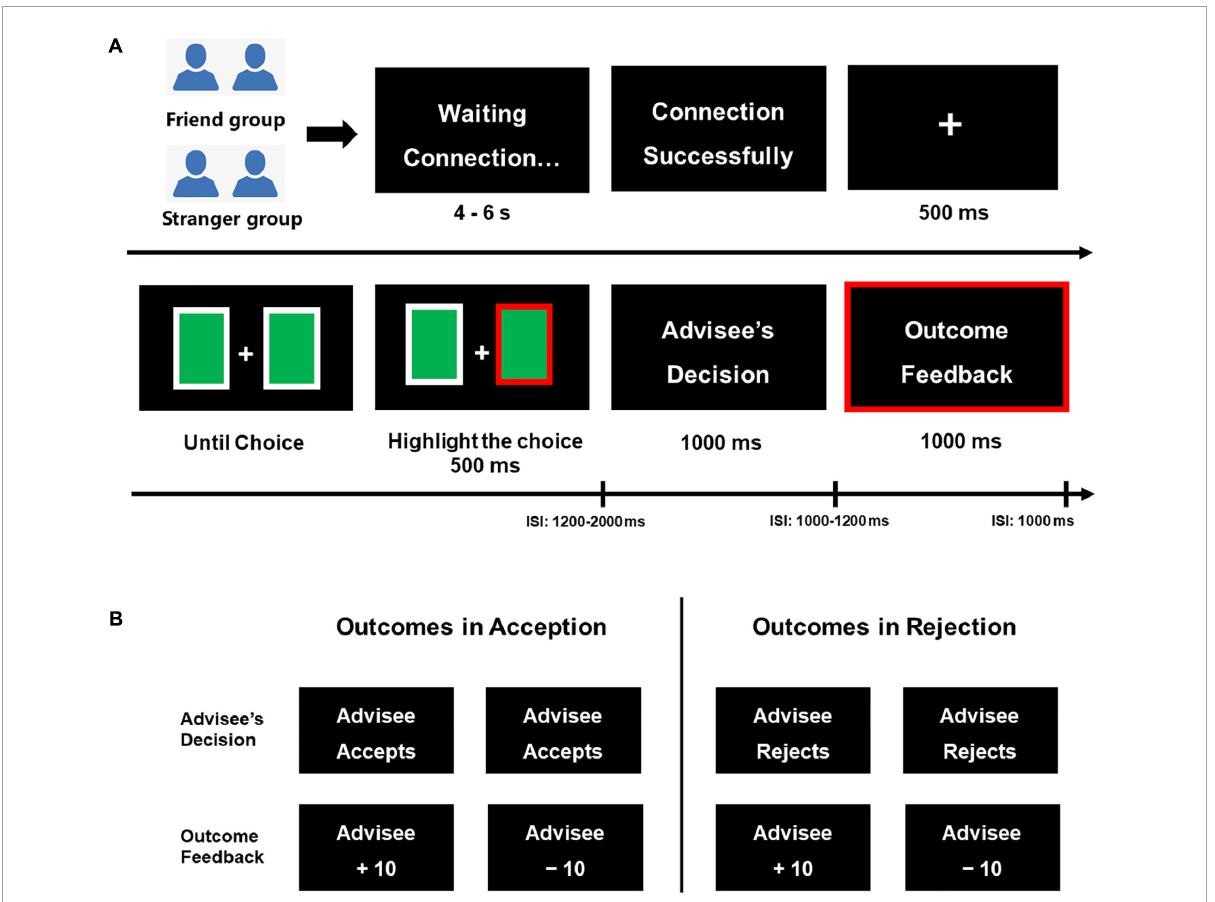
FIGURE1 Experimental procedure for the card-guessing task (A) and the advisee’s decision, outcome feedback participant could receive in each condition by choosing a card (B) .